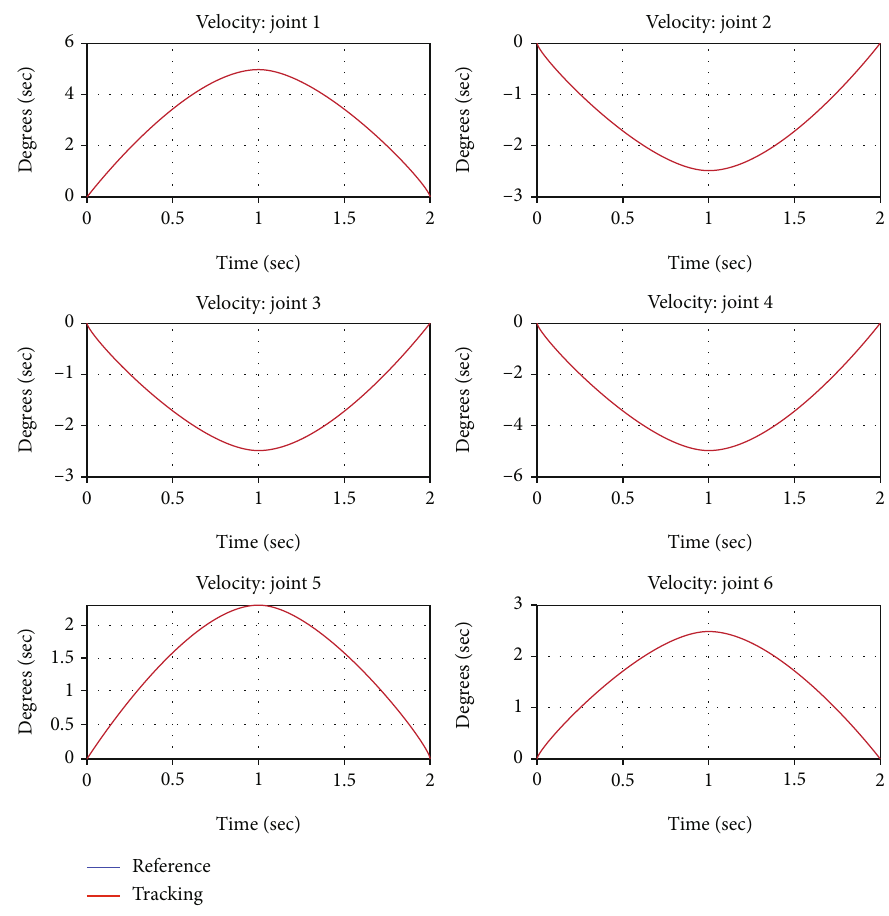
Figure 4: Tracking of the velocity reference